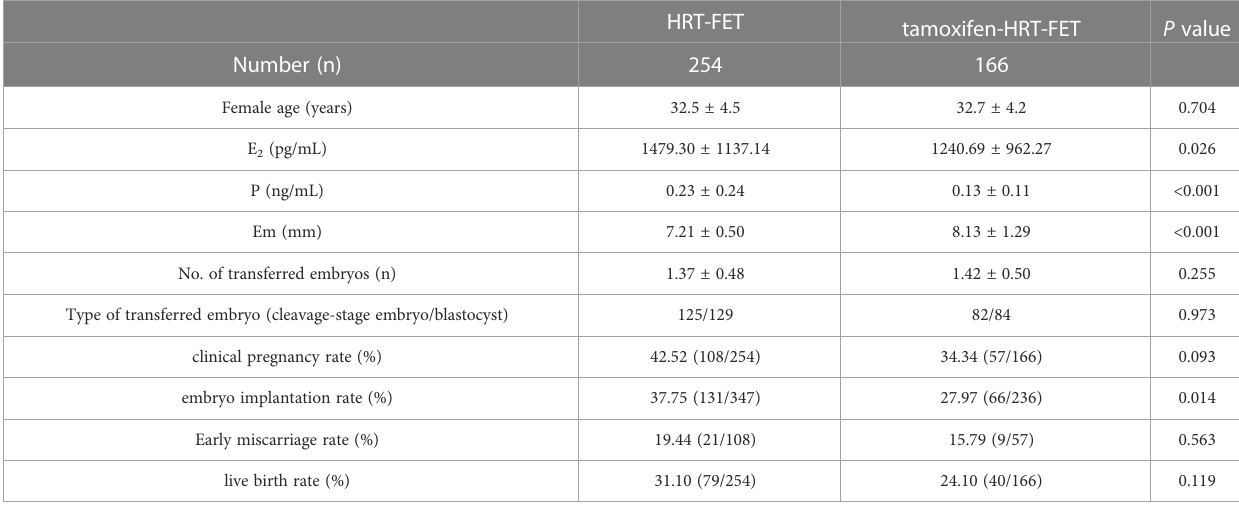
TABLE 4 General data for HRT-FET cycles versus TMXF-HRT-FET cycles.